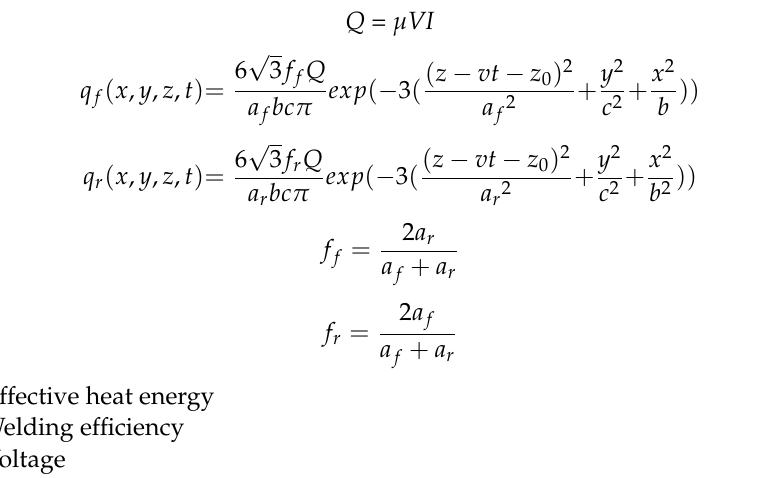
Figure 1. Heat distribution of Goldak Model [22.]